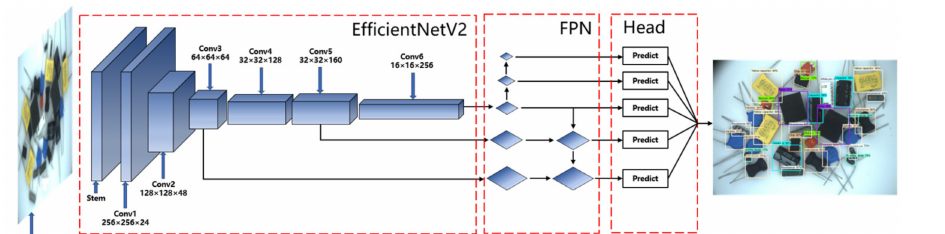
Figure 6. The overall network structure.